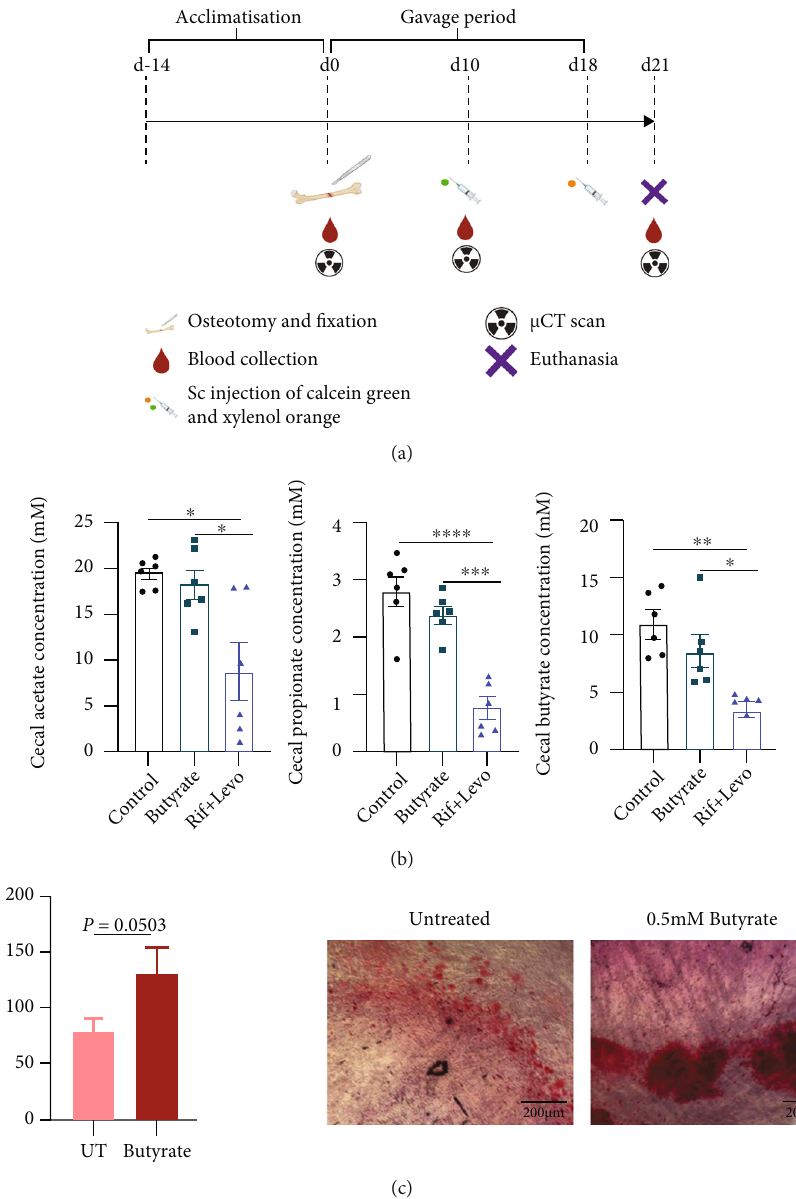
Figure 3: Rifampicin- and levo fl oxacin-treated mice show reduced cecal SCFA levels and a change in gut microbiome composition compared to butyrate- and control-treated mice. The e ff ect of butyrate on the gut microbiome, systemic immunity, and bone healing was assessed in a murine osteotomy model. (a) Experimental outline of in vivo study indicating interventions and time frame. The fi gure was created with http://BioRender.com/. (b) Cecal concentrations of acetate, propionate, and butyrate were measured by means of UPLC. Data shown are means ( n = 6 ) and ± SEM. ∗∗∗∗ p < 0 : 0001 , ∗∗∗ p < 0 : 001 , ∗∗ p < 0 : 01 , and ∗ p < 0 : 05 . (c) DNA of murine cecal content was isolated, and 16s rRNA sequencing was performed to determine microbiome composition. Percent abundance of bacterial phyla in the murine cecum ( n = 10Rif + Levo -treated animals, n = 8 butyrate-treated animals, and n = 7 control-treated